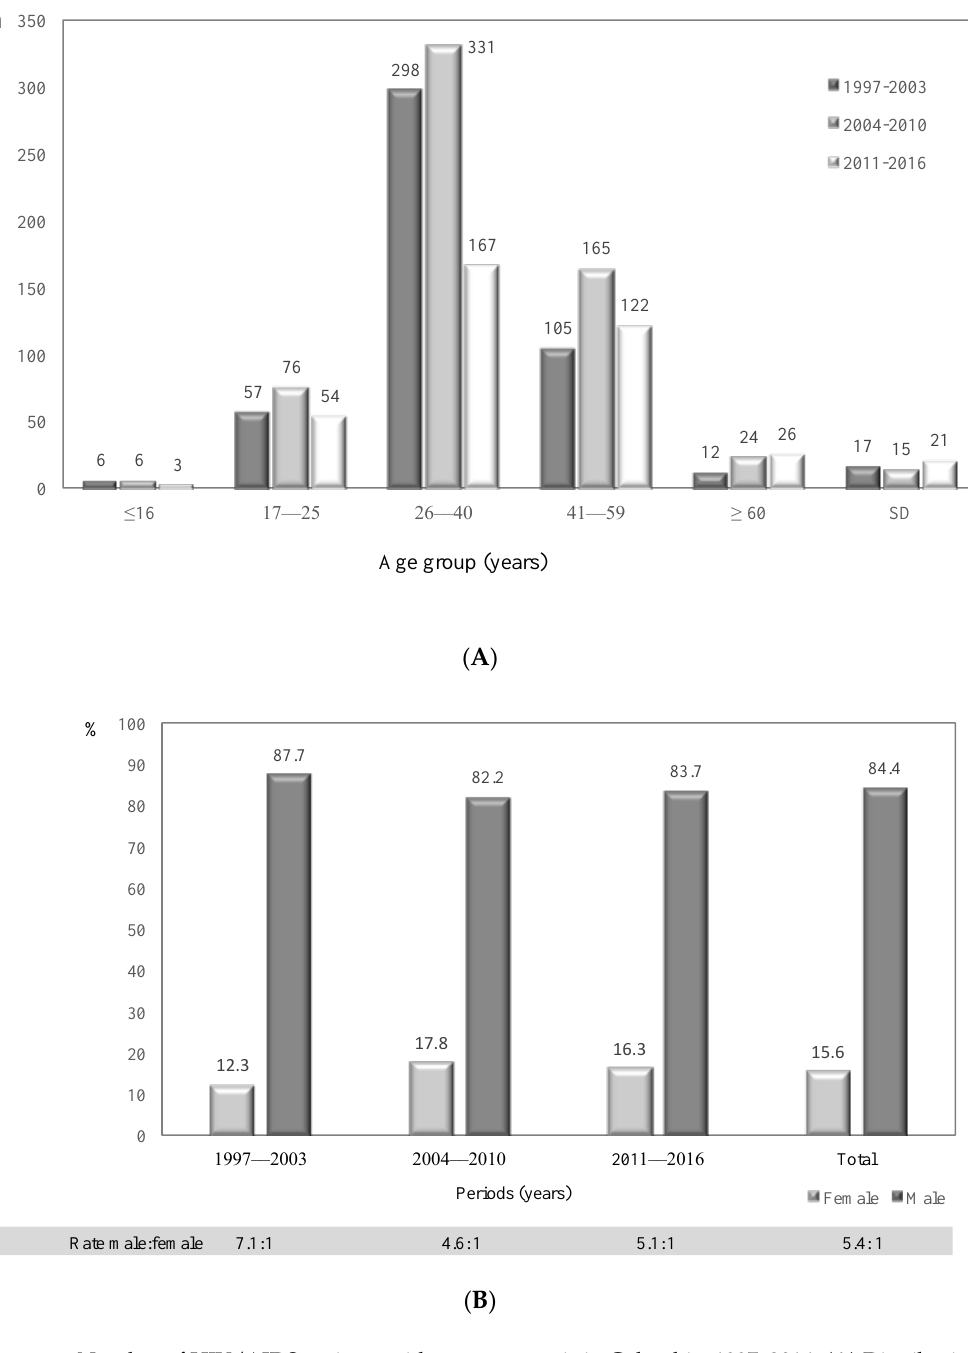
Figure 3. Number of HIV/AIDS patients with cryptococcosis in Colombia, 1997–2016. ( A ) Distribution by age group and study period; ( B ) Distribution by gender and study period.